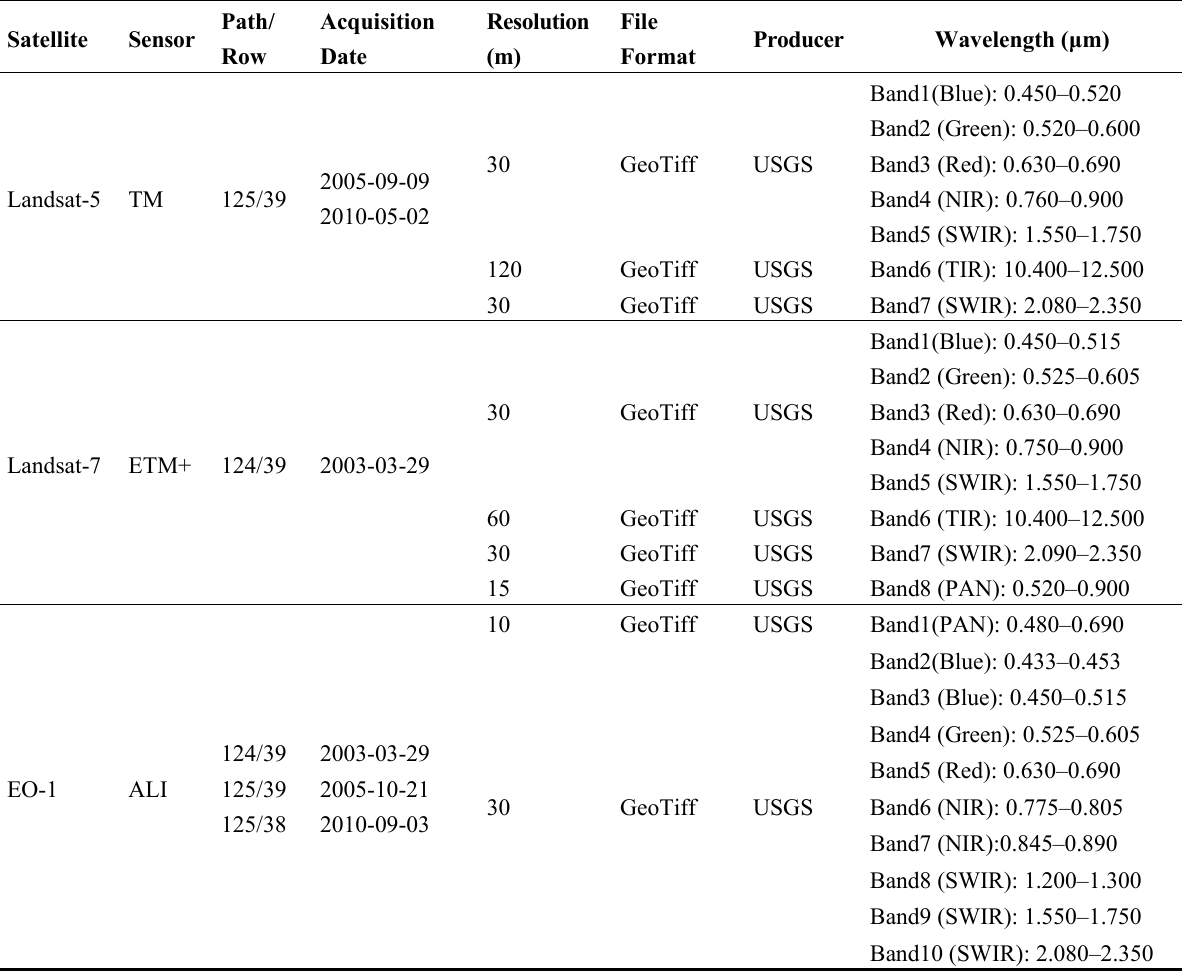
Table 1. Specifications of the Thematic Mapper (TM), Enhanced Thematic Mapper Plus (ETM+), and Advanced Land Imager (ALI) data used in this